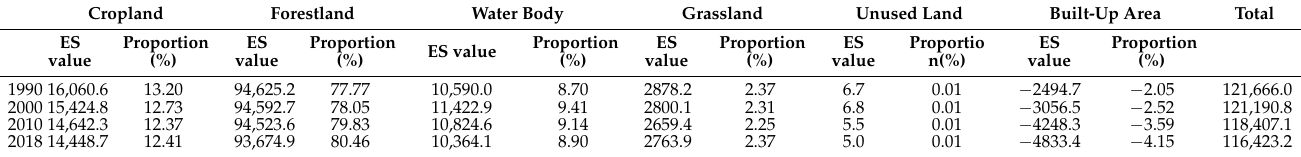
Table 7. Total ecosystem service value in Guangdong province from 1990 to 2018 (US$ million).